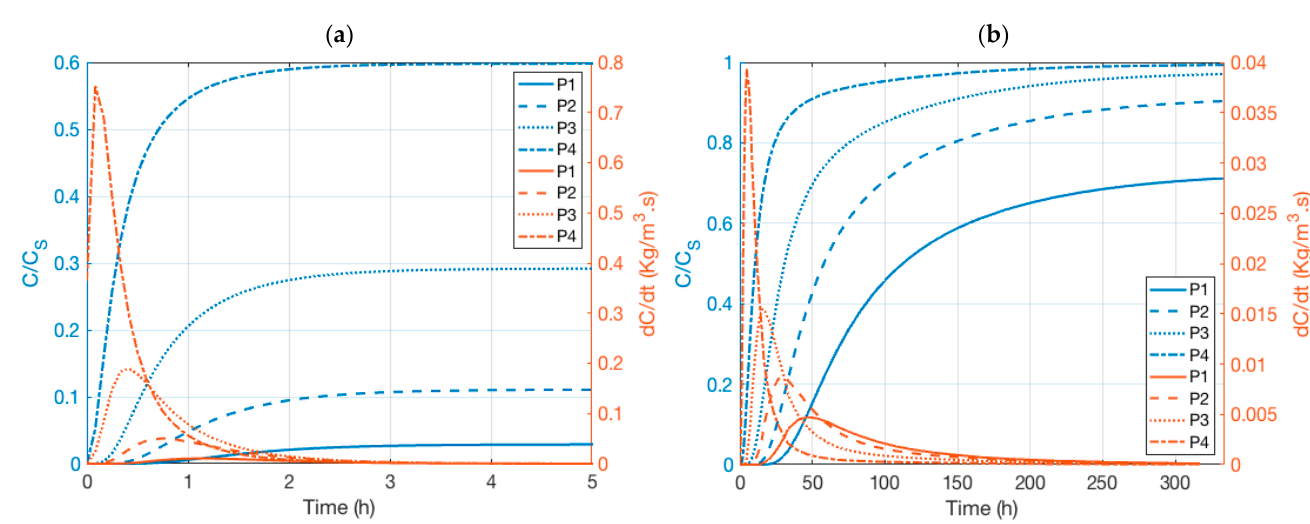
Figure 5. Time series of the normalized concentration (C/C s ) and the salinization rate (dC/dt) at observation points P 1, ... ,4 for ( a ) the standard diffusive Henry problem and ( b ) its variant with the highest pumping rate.